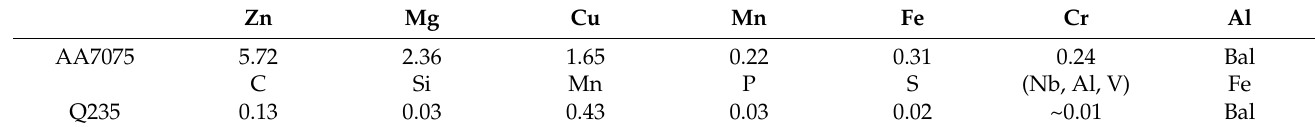
Table 1. Nominal chemical compositions (wt.%) of the studied AA7075 and Q235 steel. (Based on the certificate from Jiangsu Jianghua Valves Co., Ltd.).